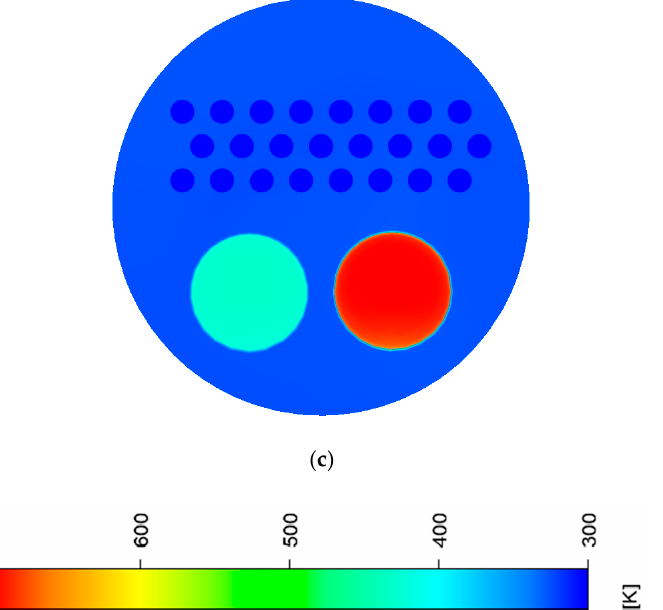
Figure 8. The distribution of temperature in the various slices inside the shell: ( a ) Slice 1, ( b ) Slice 2, and ( c ) Slice 3.